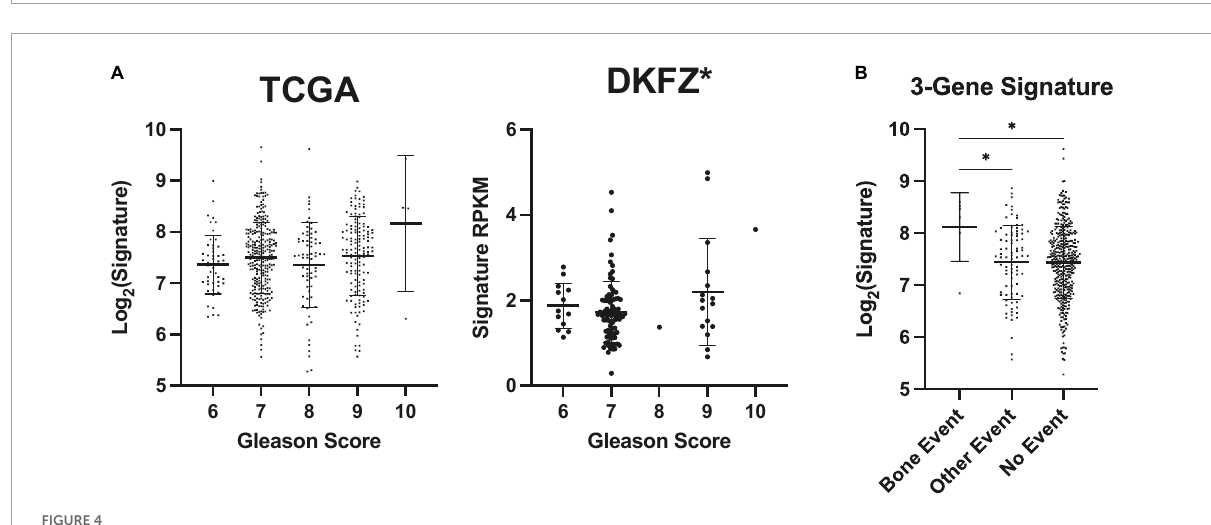
FIGURE4 ENTPD1/NT5E/ADORA3 expression level is higher in primary prostate tumors that metastasize to bone. Gleason scores reflect the undifferentiation of prostate tumors. Tumors are given two scores that are often added together such as in TCGA PRAD dataset. Tumors with higher scores are more likely to metastasize to bone and other poor outcomes (36) . (A) An increasing Gleason score is associated with higher ENTPD1/NT5E/ADORA3 expression signature in the DKFZ but not the TCGA PRAD cohort. (B) 3-gene expression signature is higher in tumors that form bone metastases, than in tumors that do not progress or cause other events. (A) One-way ANOVA with test for trend, (B) Kruskal–Wallis test with multiple comparisons. ∗ p <